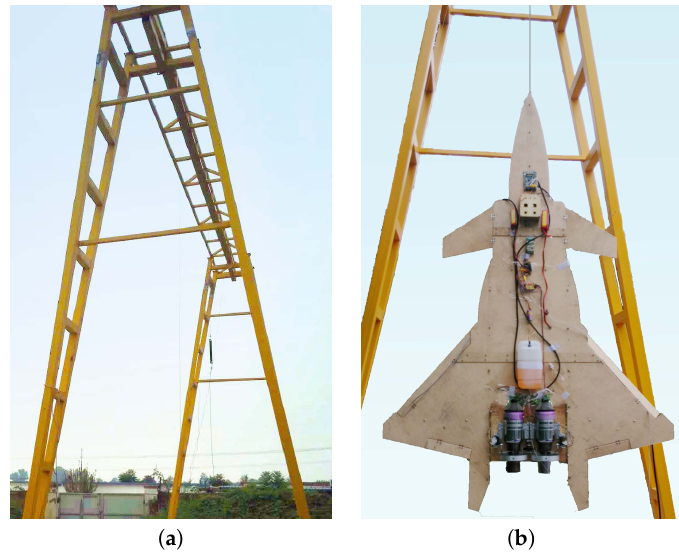
Figure 2. The experiment platform. ( a ) Gantry crane; ( b ) Suspended